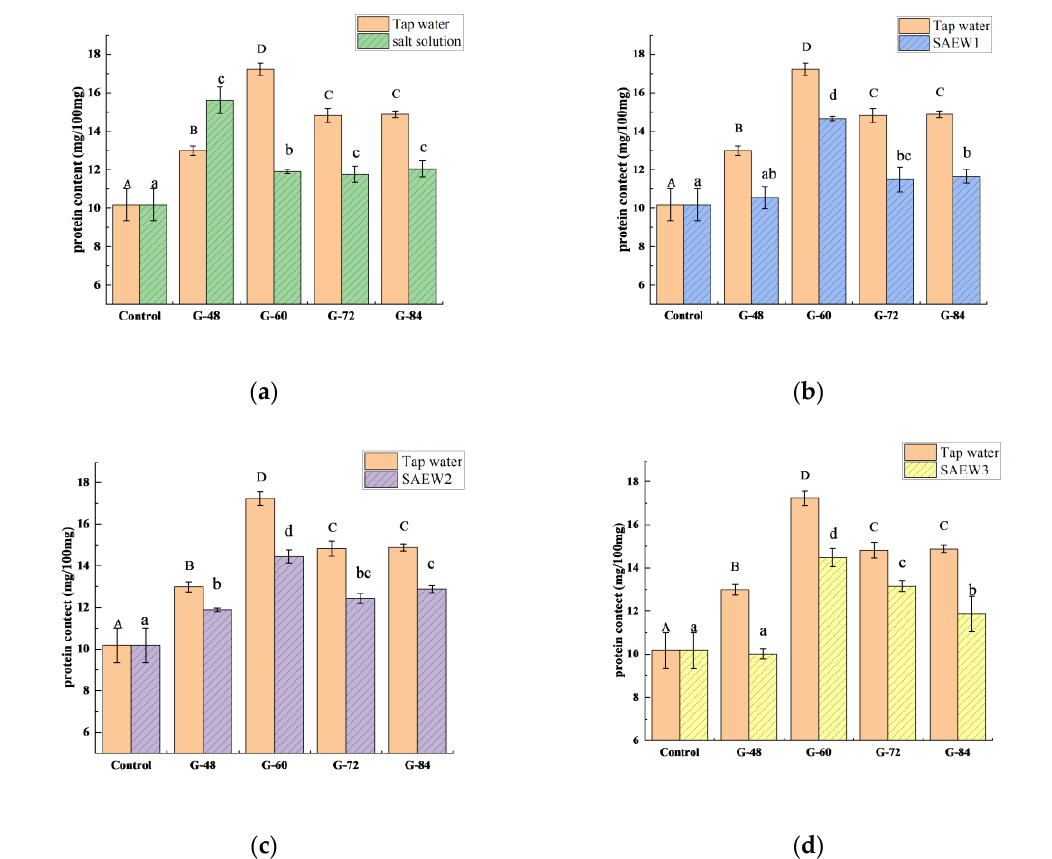
Figure 3. Effects of different germination conditions on the protein contents in germinated millet flour: ( a ) salt solution; ( b ) SAEW1; ( c ) SAEW2; ( d ) SAEW3. SAEW, slightly acidic electrolyzed water; SAEW1, 2, and 3 represent SAEW with ACC concentrations of 10.92, 20.25, and 30.35 mg/L, respectively; control, ungerminated millet flour; G-48, 60, 73, and 84 indicate germination for 48, 60, 73, and 84 h, respectively. Different capital letters indicate significant differences for tap water treatment and lowercase letters indicate significant differences for other sample solution treatments ( p < 0.05). Each value is expressed as the mean ± standard deviation of three